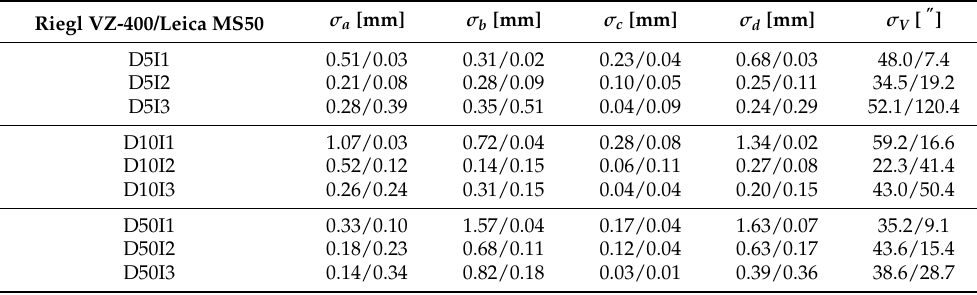
Table 4. Precision of the computed parameters: tilt test.